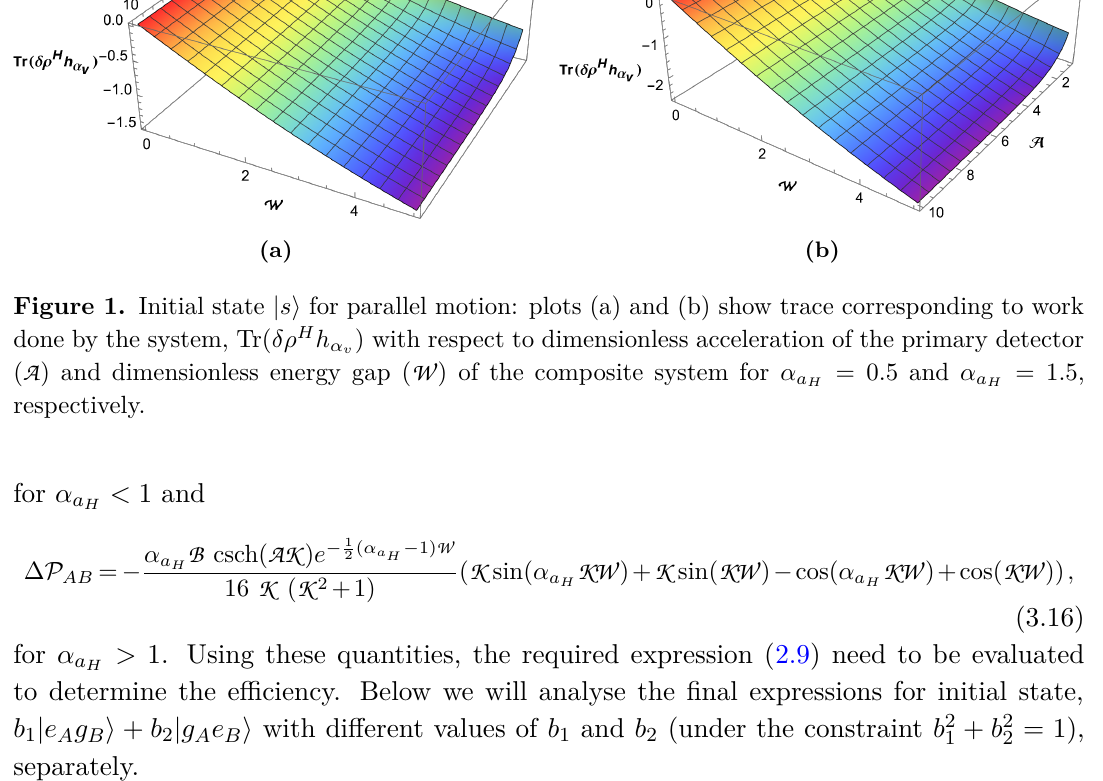
) with respect to dimensionless acceleration of the primary detector α v